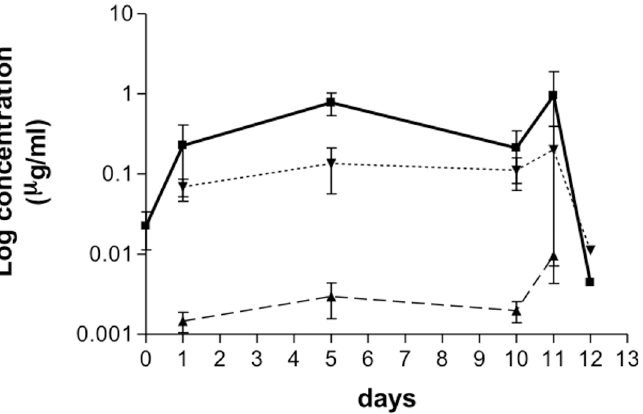
Fig 4. Pharmacokinetic of oxfendazole in dogs treated for 10 days with oxfendazole. Mean (± s.e.m.) blood concentrations (μg/mL) of oxfendazole (square) and its metabolites fenbendazole (triangle) and fenbendazole-sulfone (triangle) following oral administration of 50 mg/kg b.w. for 10 days in dogs (n =